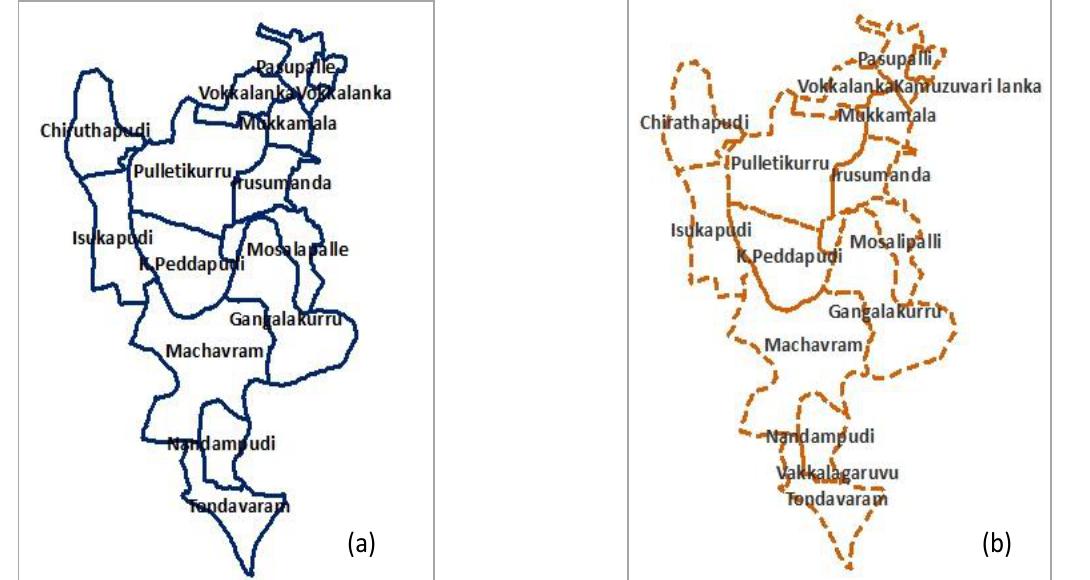
Figure 7: (a) Village boundary of the study area and (b) Panchayat boundary of the study area